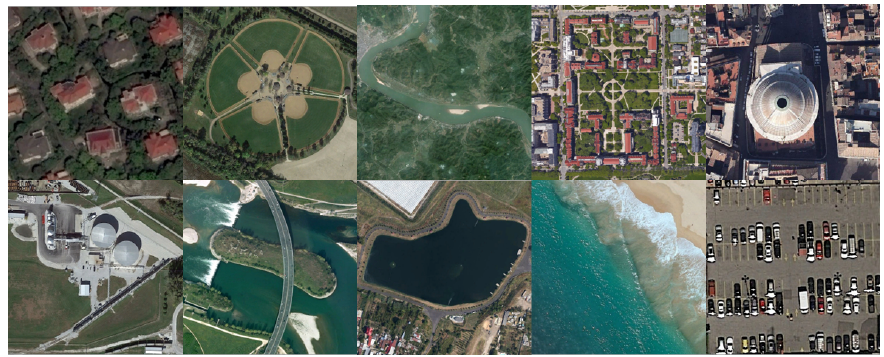
Figure 11. Samples of the AID dataset.